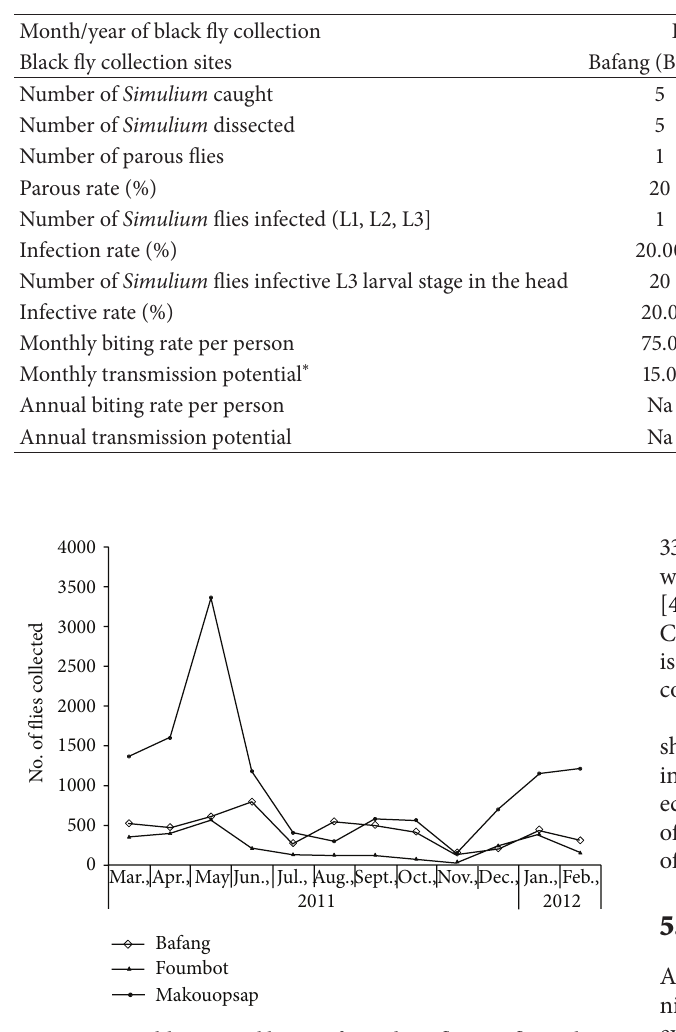
Figure 3: Monthly seasonal biting of Simulium flies at 3 fly catching sites in West